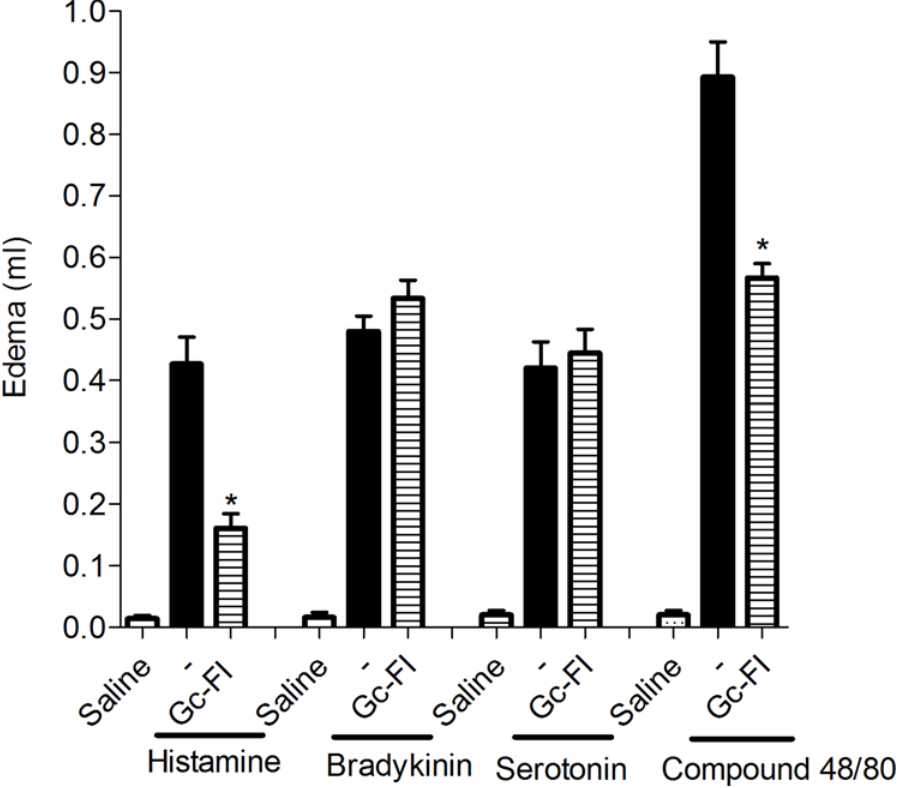
Fig 3. The anti-inflammatory effect of Gc-FI involves the inhibition of histamine and compound 48/80. Mean ± SEM (%, n = 6) (ANOVA, Bonferroni ’ s test). * p < 0.05 compared to stimuli.